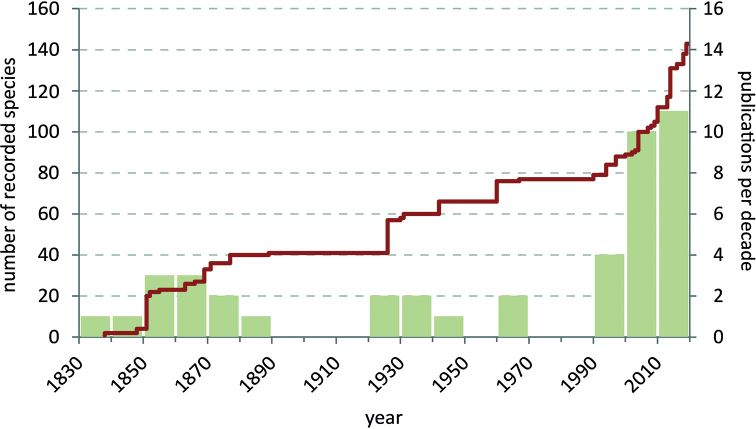
Cumulative increase of the number of Norwegian species records of Sciaridae (red line) and the number of corresponding publications (bars) containing first records per decade until 31 December 2019.